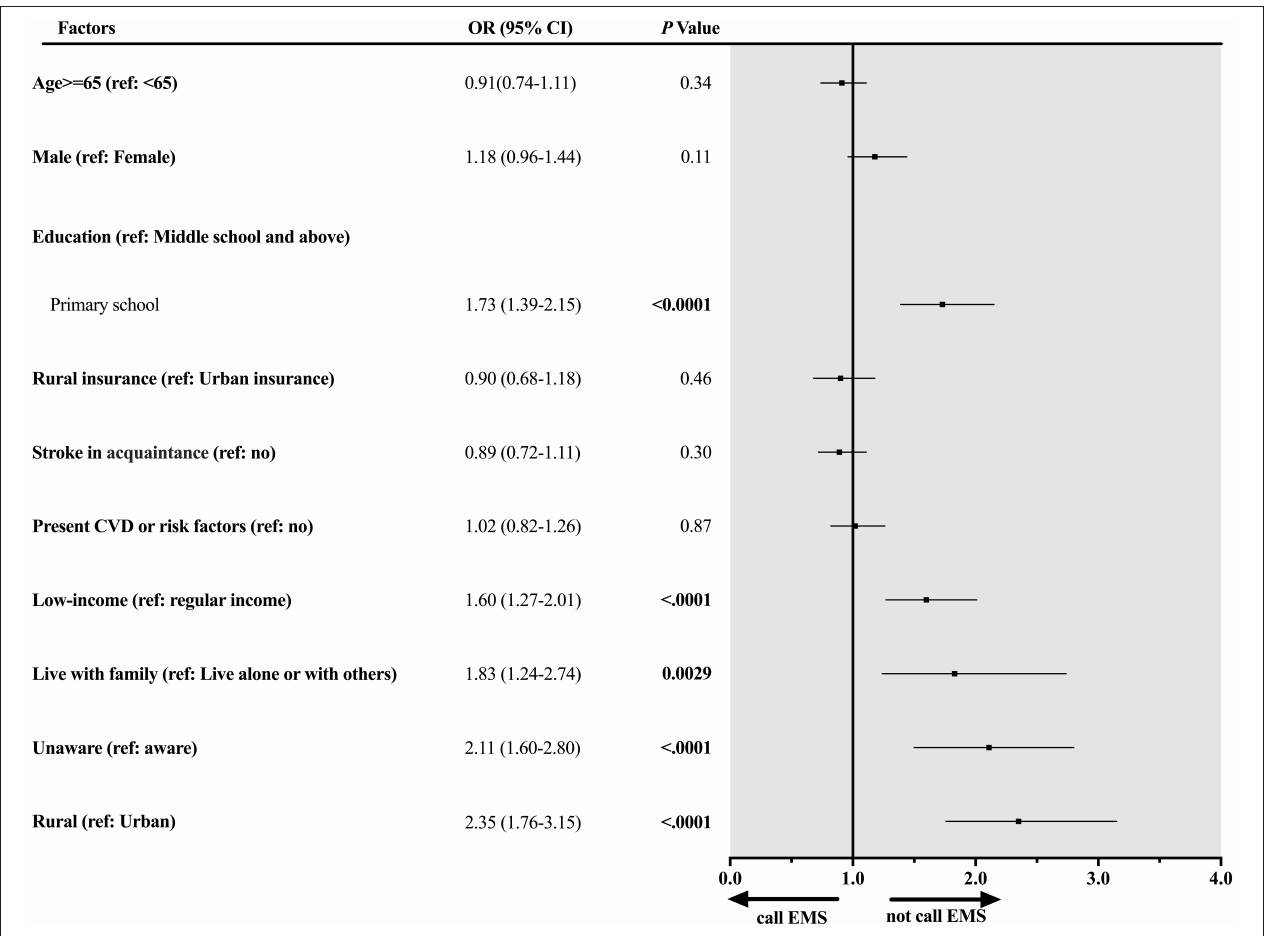
FIGURE 1 | Factors associated with not calling EMS among all participants with previous TIA. Forest plot and corresponding statistical results (OR, 95% CI, and p- value) illustrate risk factors associated with not calling EMS among all participants with previous TIA.